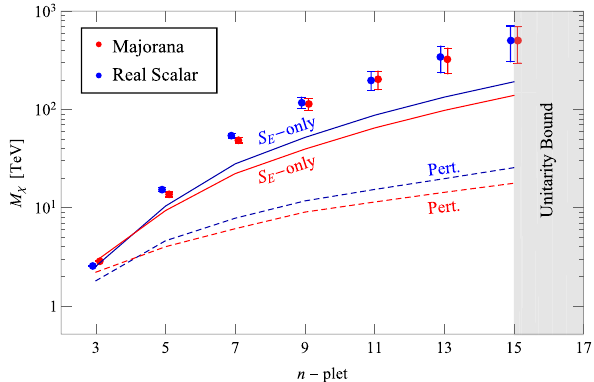
Fig. 1 Summary of the thermal masses for Majorana fermion (red) and real scalar WIMPs (blue) including both Sommerfeld enhancement (SE) and bound state formation (BSF). The solid lines are the thermal masses with SE. The dashed lines are the thermal masses for the hard annhilationcross-section.Thegrayshadedregionisexcludedby s -wave perturbative unitarity including